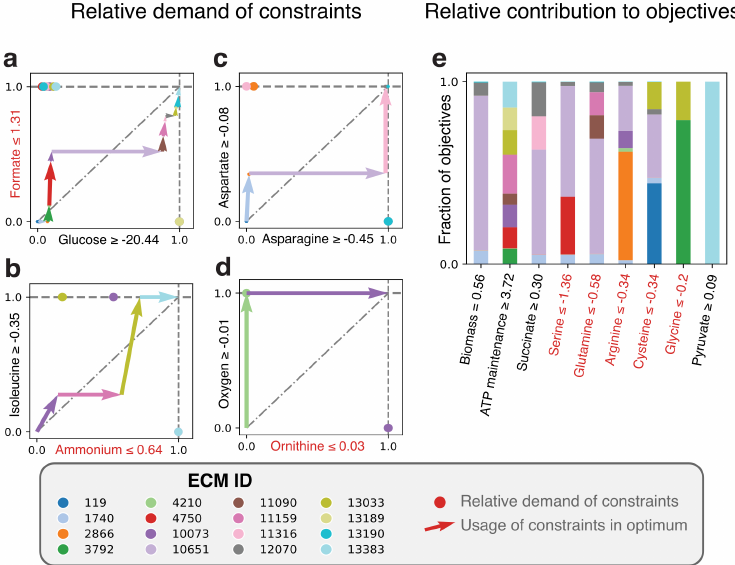
Figure 4. Elementary Modes-based analysis reveals the costs and benefits of all metabolic strategies that constitute the optimal solution of Lactococcus lactis in rich medium. ECMs were enumerated for the active network of a L. lactis genome-scale metabolic model [18] which was constructed based on measurements from [37]. ( a – d ) The costs of all the used EMs for the 8 different constraints. The pairing of the constraints in the plots is based on their scaled reduced costs, which quantifies how strongly the constraint limits the production of biomass. Glucose-limitation forms the strongest constraint, followed by formate, ammonium, etcetera. In principle, the relative costs between all pairs of constraints can be plotted. The constraints written in red are special: these force L. lactis to produce a certain minimal amount of product. ( e ) The contribution of each EM to the biomass objective and the secondary objectives. The secondary objectives are ordered based on their scaled reduced costs. Objectives written in red are special again: these do not demand the minimal production of something, but rather demand a certain minimal uptake